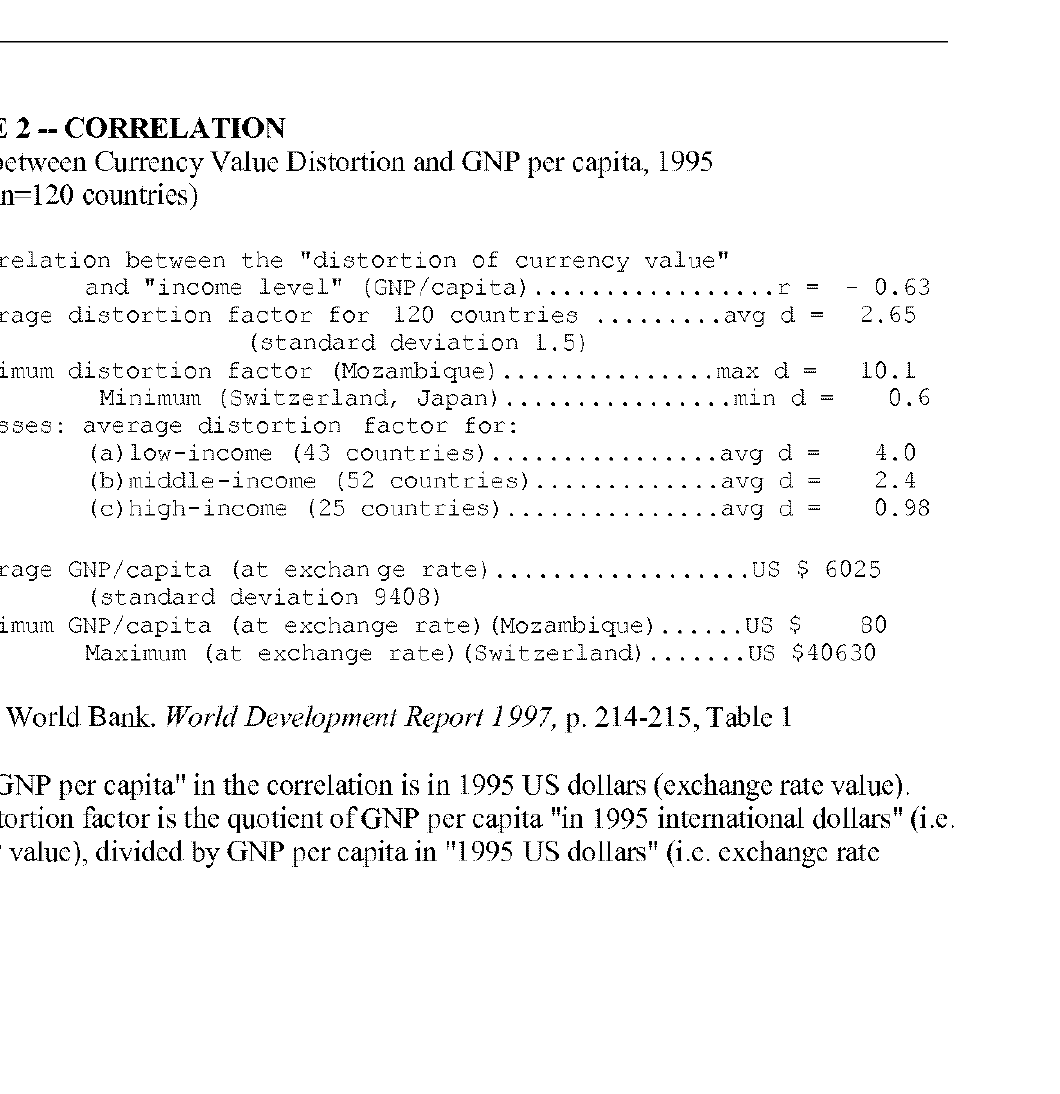
between Currency Value Distortion and GNP per capita, 1995 (n= 120 countries)